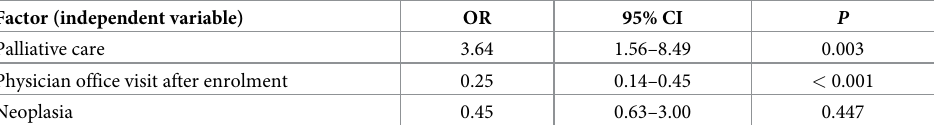
Table 4. Multivariate analysis of factors associated with mortality (independent variable) among patients enrolled in an outpatient parenteral antimicrobial therapy program at facilities within the Santa Helena/Amil